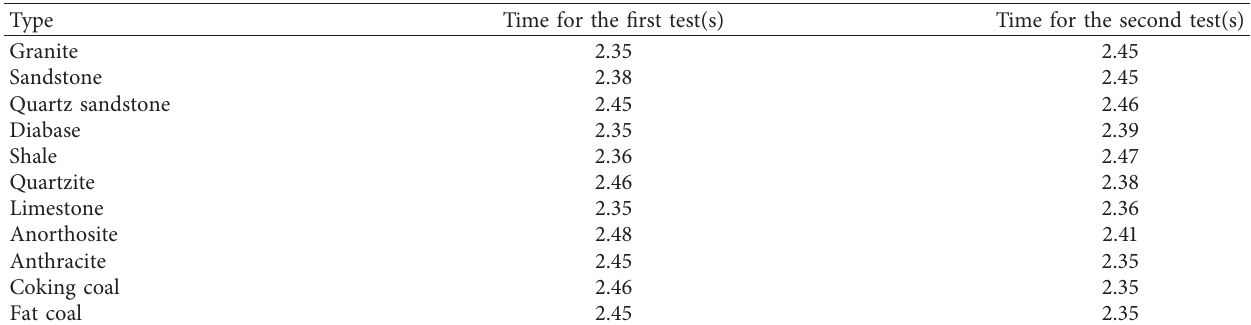
Table 5: Time for identify